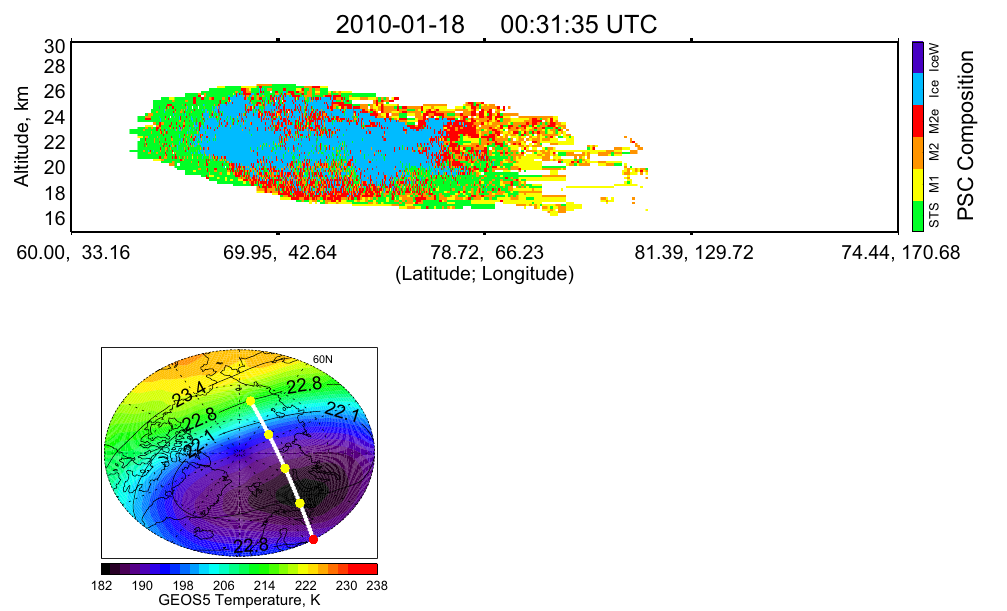
Fig. 8. CALIPSO PSC composition observation for the orbit starting on 18 January 2010 at 00:19UT (top) and GEOS-5 temperatures and geopotential height fields at 30hPa at 12:00UT (right). The white line marks the CALIPSO orbit track. 150 o W